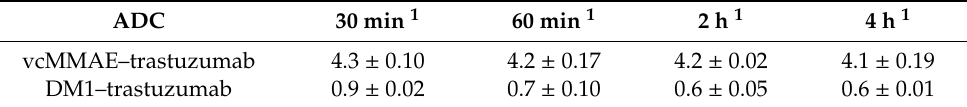
Figure 2. Observed shift in charge envelope towards lower mass-to-charge values for N -succinimidyl 4-(maleimidomethyl)cyclohexanecarboxylate (SMCC)-DM1 (DM1)–trastuzumab when subjected to disulfide reduction for ( a ) 30 minutes and ( b ) 60 minutes. Table 1. Average DAR-values of ADCs subjected to reduction for di ff erent incubation